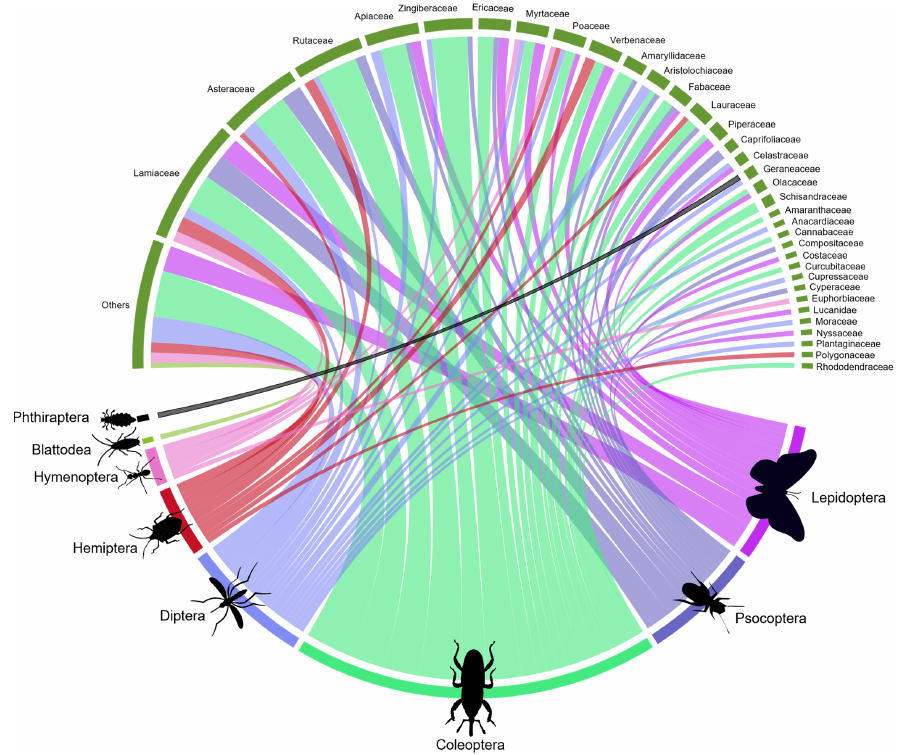
Figure 4. Interaction between the diversity of plant families and insect orders studied from the bibliographic survey of articles on insecticidal phytochemicals. The thickness of the bar and line under each plant family and insect order connecting them corresponds to the relative number of articles dealing with the said insect groups and molecules derived from plant groups; the thicker the bar and line, the larger the number of studies. (Number of papers = 138. However, there are repeated measures, since a paper may contain more than one insect order and/or botanical family; therefore, n = 162).